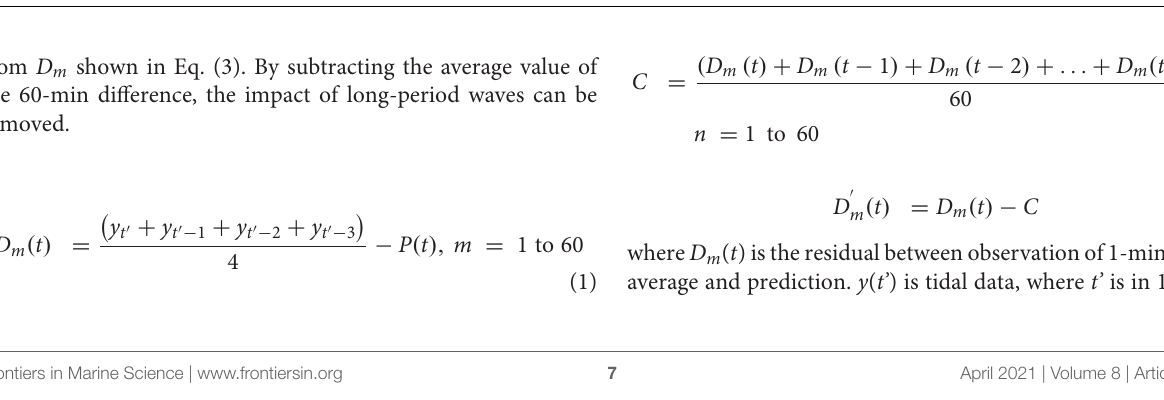
FIGURE 7 | Analysis of the trend of sea level rise by tide stations along the coast of Taiwan. This is a snapshot of the screen of the SLR module of TwMEMS.